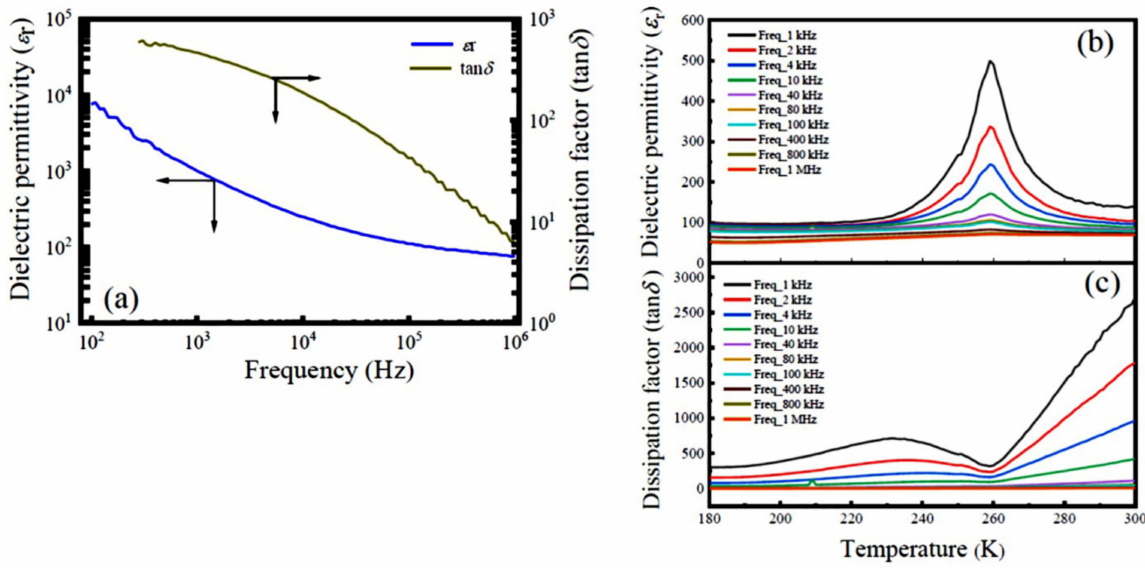
Figure 6. ( a ) Room temperature frequency dependence of the dielectric permittivity ( ε r ) and dissi- pation factor (tan δ ) of the LNMO ceramics prepared from NRs. ( b , c ) Corresponding temperature dependence of the dielectric permittivity and dissipation factor of the LNMO ceramics measured at different